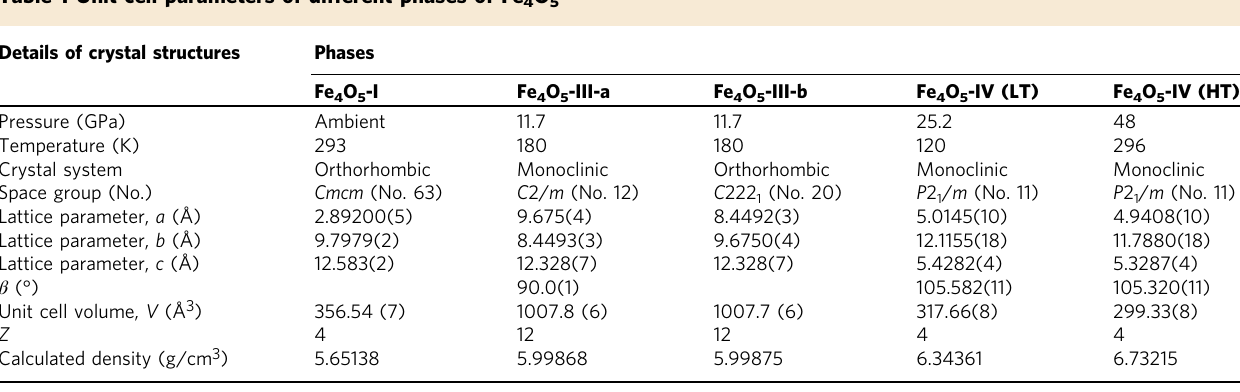
chains, and values to be 0.93, 0.90, and 0.88, respectively (Supplementary Table 4). This difference in the d units ratios may be referred to the above average BVS values of Fe1, Fe2, and Fe3 atoms, which should approximately correspond to their oxidation states. In fact, the shortest iron dimers are formed in the double chains of Fe3 octahedra with an average BVS value